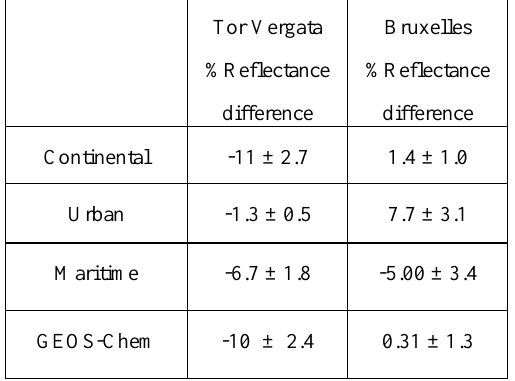
Table 4. Mean and standard deviation of the relative differences of reflectances obtained with different aerosol models (continental, urban, maritime, and GEOS-Chem) with respect to those obtained with the AERONET model, for the two CHRIS images.